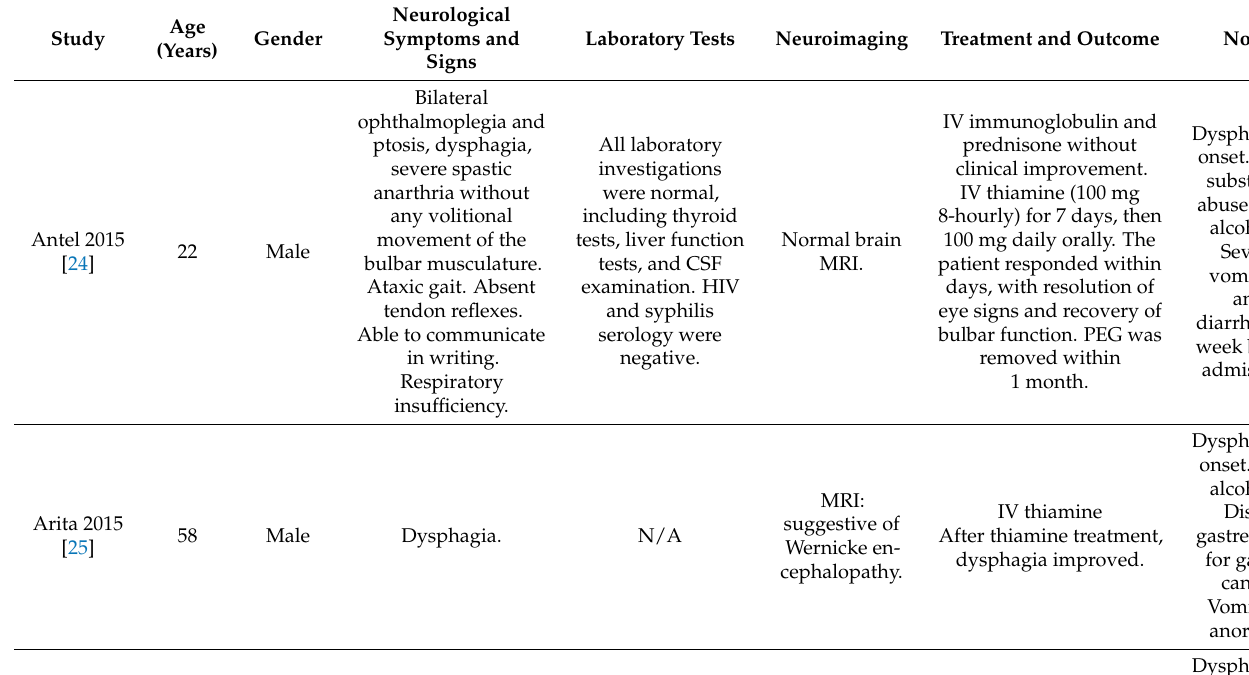
Table 1. Characteristics of the included